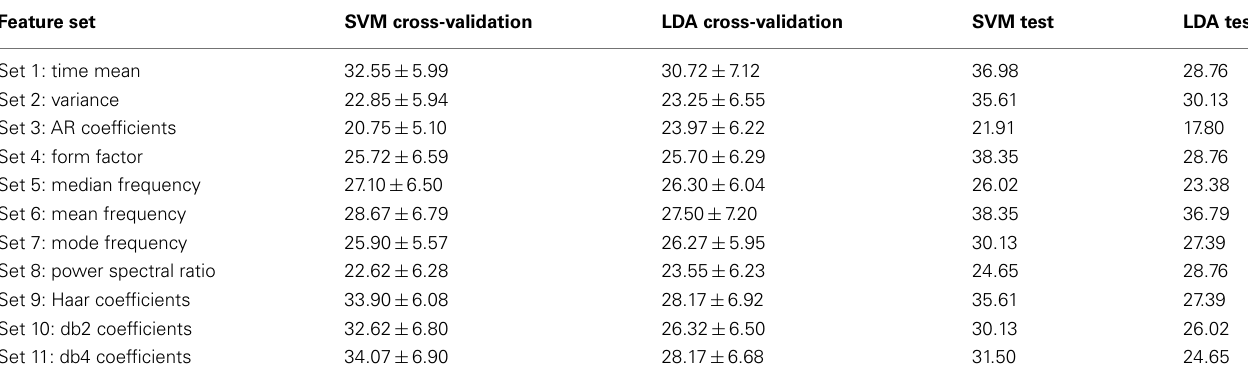
Table 3 | Classification accuracy (%) achieved by using different feature sets on the cross-validation and test data for subject 2. Feature